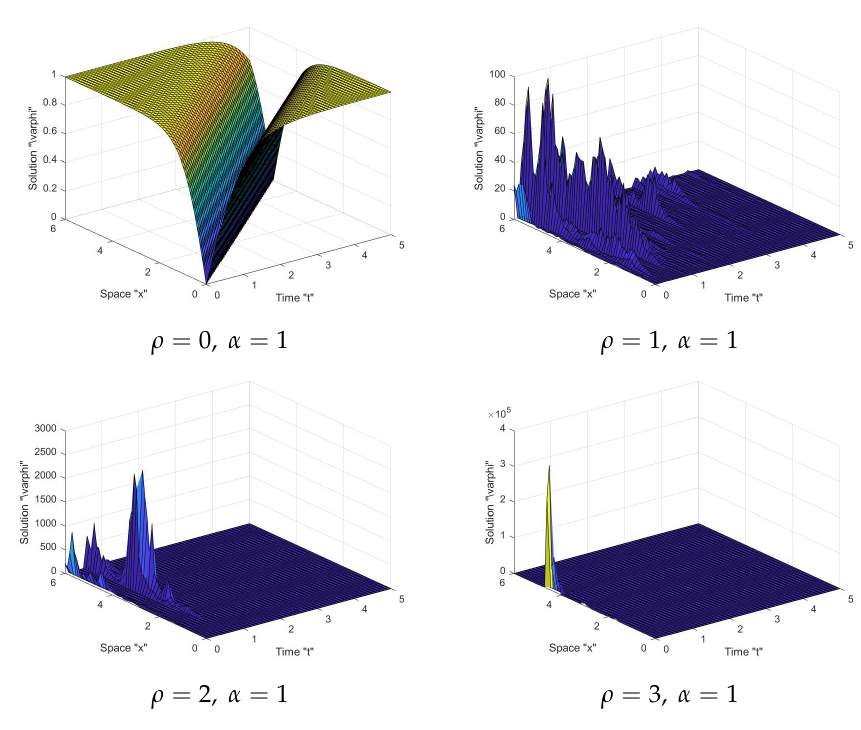
Figure 3. Graph of solution | ϕ 5 | in Equation (15) with ω 1 = − 1, ω 2 = − 2 and α = 1.